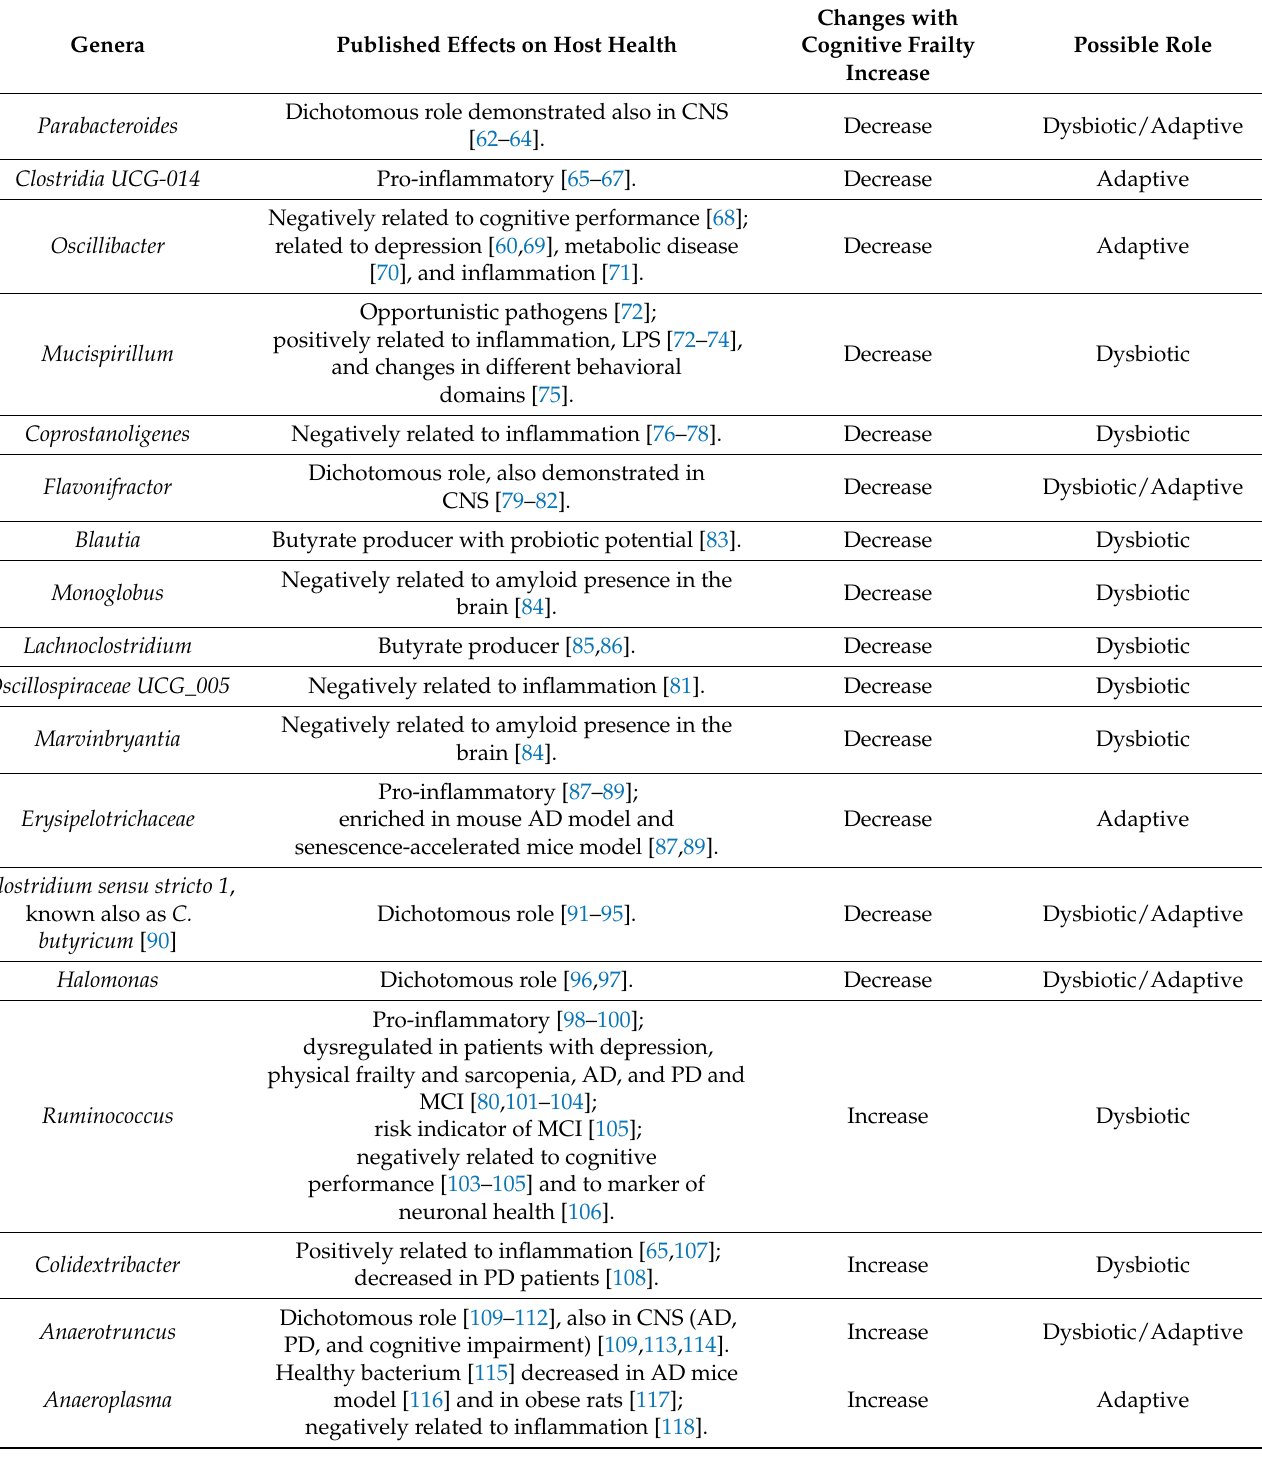
Table 3. Proposed dysbiotic or adaptive roles of gut bacteria that significantly changed with Cognitive Frailty Index. We searched in the literature the involvement of selected bacteria on host health, and in particular, on